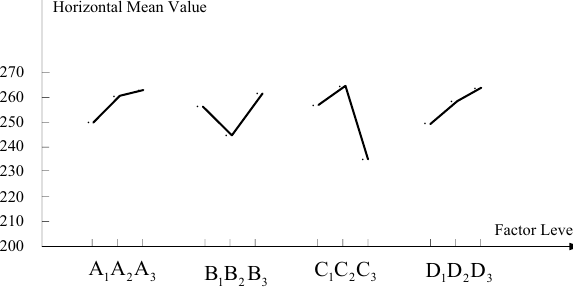
Fig. 15 The Response Trend of Weighted Acceleration RMS Value